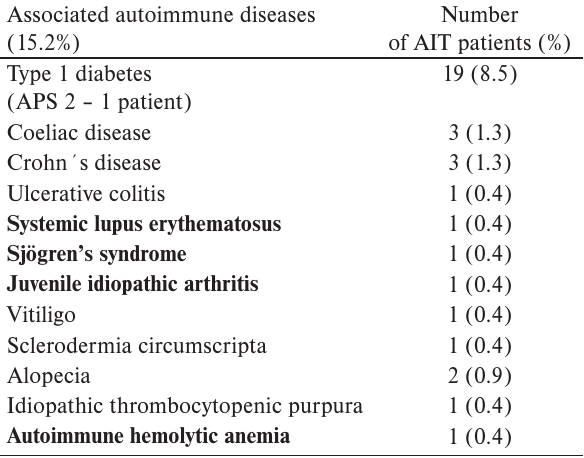
Table 3. Frequencies of autoimmune diseases in AIT cohort